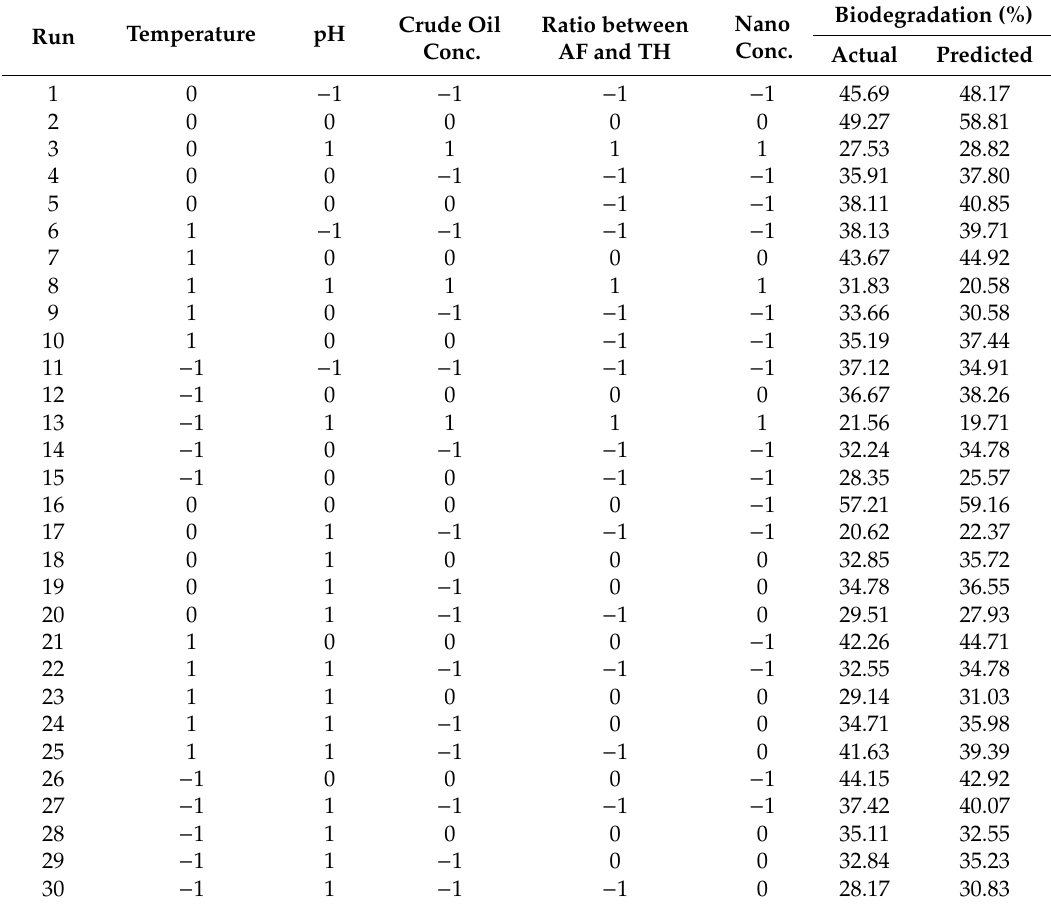
Table 5. Full-factorial Box-Behnken design matrix of 5 independent variables and mean response for biodegradation percentage of crude